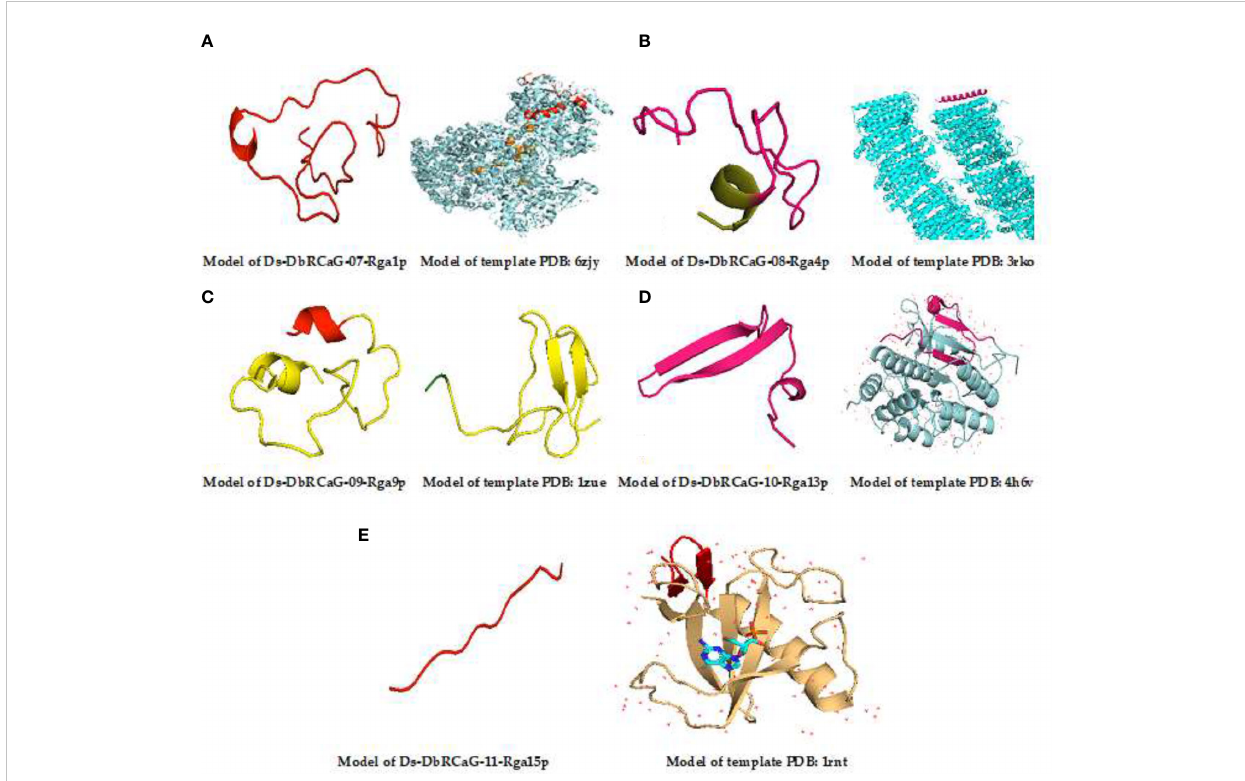
FIGURE 2 3D homology modeling of Ds-DbRCaG-07-Rga1p, Ds-DbRCaG-08-Rga4p, Ds-DbRCaG-09-Rga9p, Ds-DbRCaG-10-Rga13p, and Ds-DbRCaG-11- Rga15p. The homology regions of the template model and the predicted protein model of each identi fi ed RGA are displayed in the same color scheme. (A) Predicted protein structure of Ds-DbRCaG-07-Rga1p. (B) Predicted protein structure of Ds-DbRCaG-08-Rga4p. (C) Predicted protein structure of Ds-DbRCaG-09-Rga9p. (D) Predicted protein structure of Ds-DbRCaG-10-Rga13p. (E) Protein structure of Ds-DbRCaG-11-Rga15p. The secondary structure model of each template was obtained from the RCSB protein database.